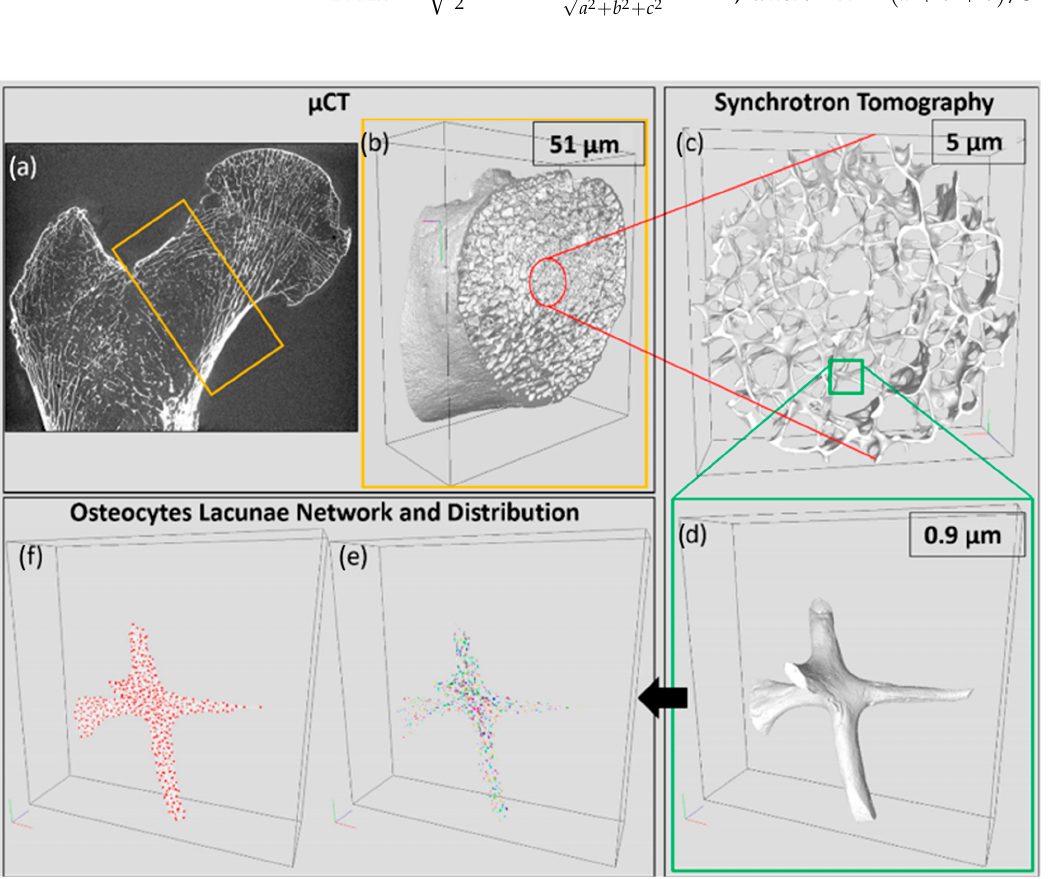
Figure 3. Multiscale characterization of femoral neck morphology acquired using µCT (voxel size: 51.0 µm) and SRµCT (voxel size: 4.95 and 0.9 µm). ( a ) Proximal femur coronal plane acquired using µCT at 51.0 µm showing the femoral neck ROI (orange rectangle) used to assess clinical-standard bone mineral density by dual-energy X-ray absorptiometry; ( b ) whole femoral neck acquired using µCT at 51.0 µm; ( c ) central core of the femoral neck trabecular phase scanned using SRµCT at 4.95 µm; ( d ) single trabecula acquired using SRµCT at 0.9 µm; ( e ) OL distribution and ( f ) OL network.